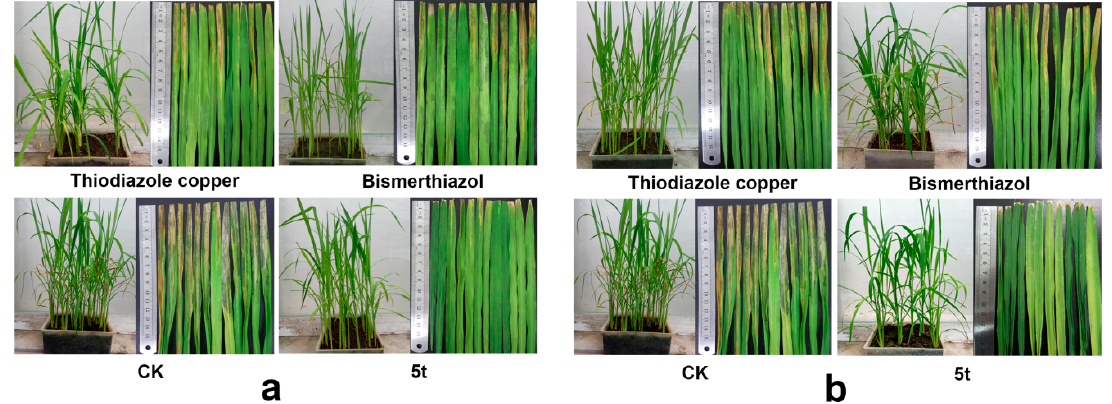
Figure 2. Protective ( a ) and curative ( b ) activities of compound 5t against rice bacterial leaf blight. Table 3. Protective activity of compound 5t against rice bacterial leaf blight.